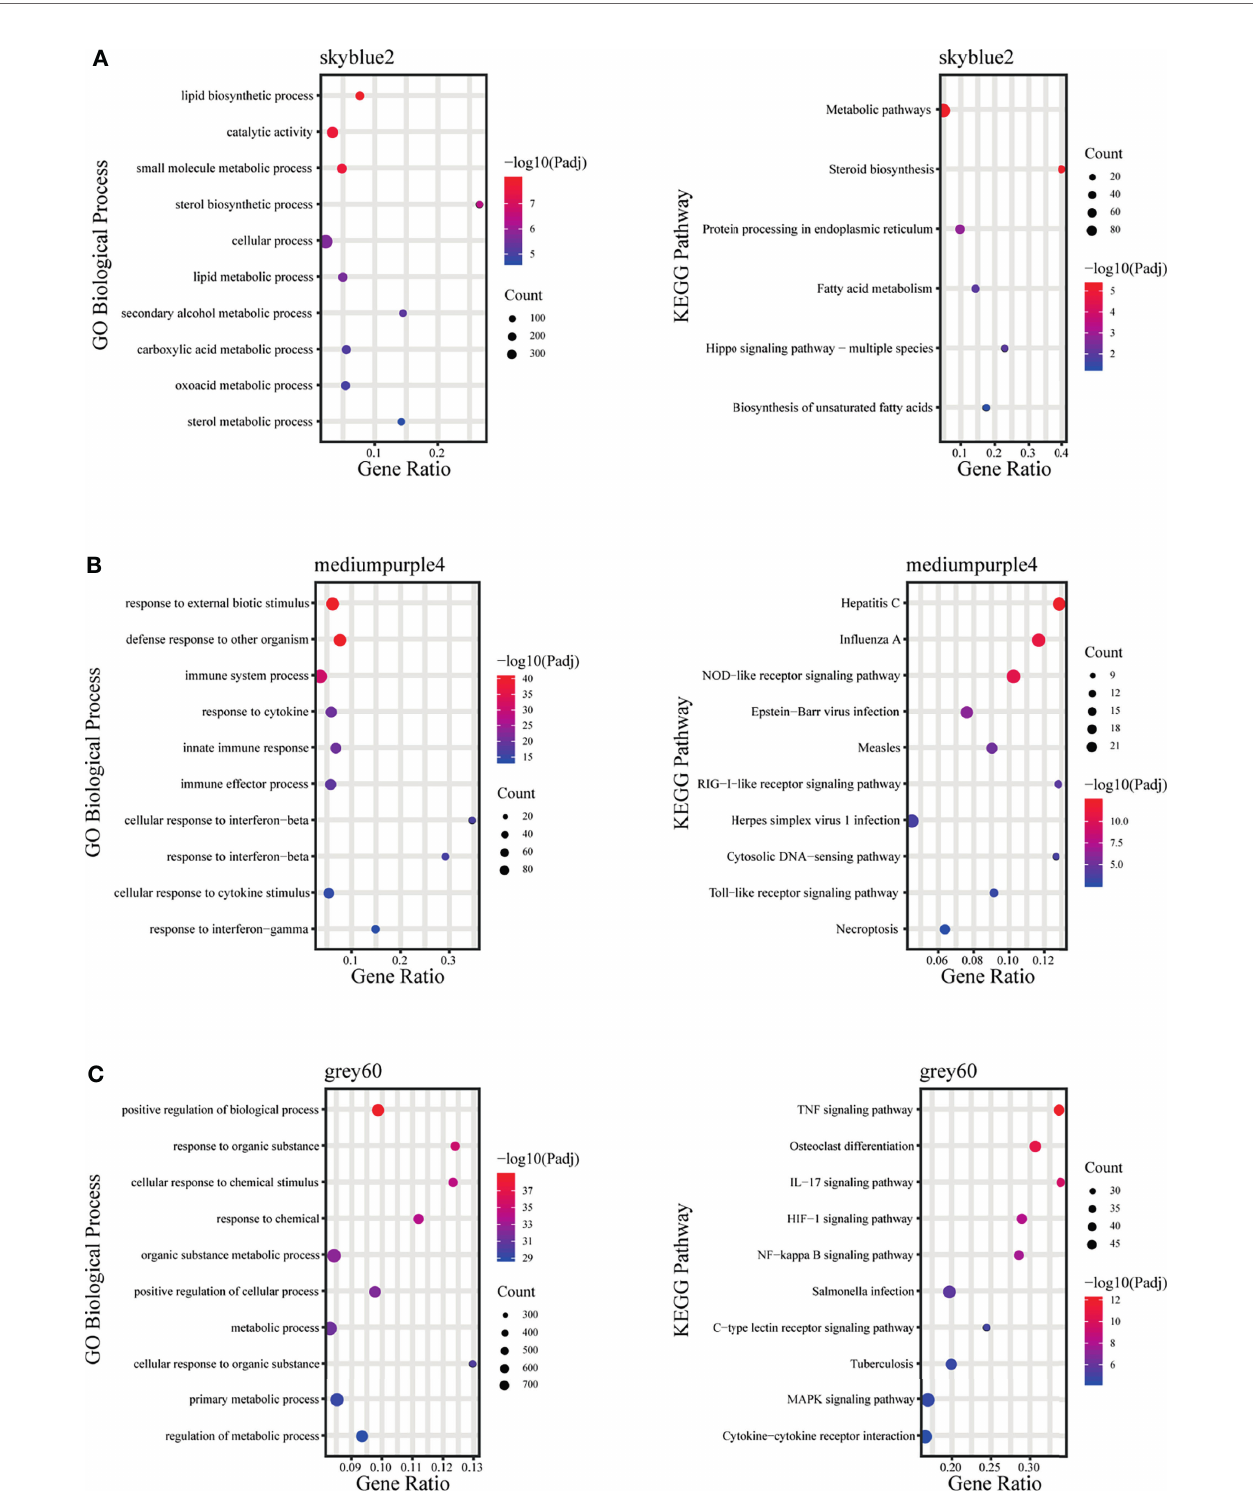
FIGURE 5 | Fold enrichment of top-level overrepresented GO terms (biological process) and KEGG terms within modules that are highly positively correlated with different infection stages. (A) skyblue2 module, (B) mediumpurple4 module, (C) grey60